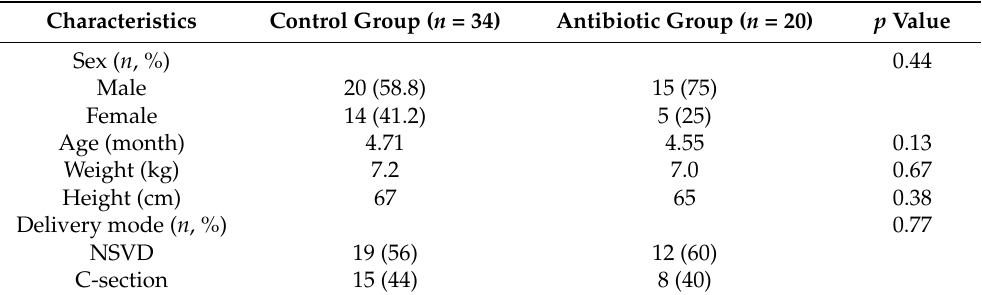
Table 1. Baseline characteristics of children in control and antibiotic treatment group. Characteristics Control Group ( n =